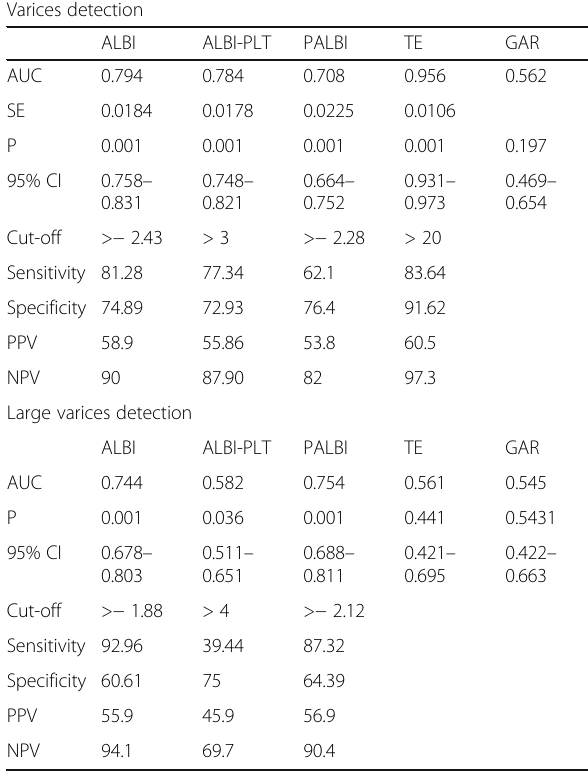
Table 3 Receiver operating characteristic (ROC) curve analysis of TE, ALBI, ALBI-PLT, and PALBI in patients with and without esophageal varices and small versus large varices Varices